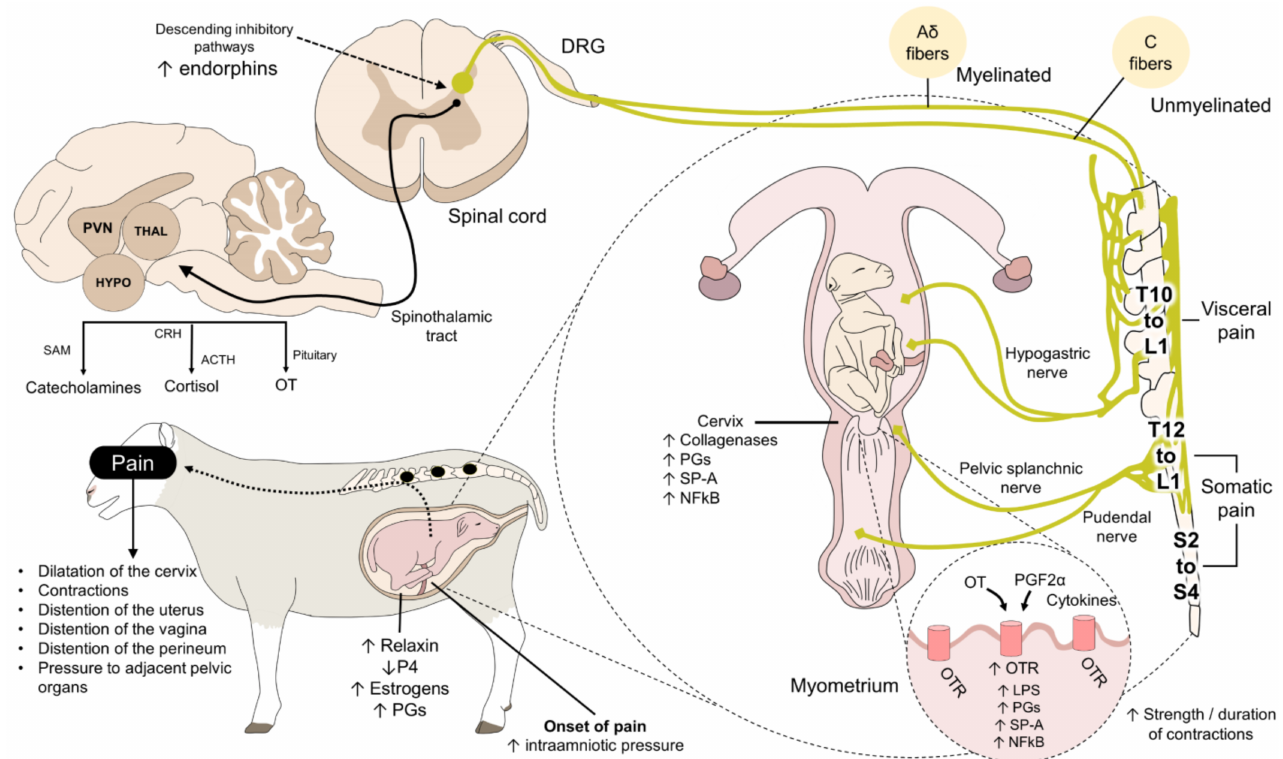
Figure 1. Neurobiology of pain during parturition. With the onset of labor and its clinical signs, such as cervical dilation, myometrial contractions, uterine distention, and increased concentrations of PG, estrogen, collagenase, and other mediators, a nociceptive response is detected by A δ and C fibers. These neurons transmit sensations of visceral and somatic pain to the dorsal horn of the spinal cord, where interneurons modulate and project to supraspinal centers to trigger the conscious perception of pain. Brain areas such as the HYPO and PVN are responsible for generating physiologi- cal responses that trigger secretion of catecholamines, glucocorticoids (cortisol), and OT. OT is the main hormone associated with the onset and maintenance of labor. Its secretion, together with PGF2 α and cytokines, activates OTR to increase the strength, frequency, amplitude, and duration of my- ometrial contractions. ACTH: adrenocorticotropic hormone; CRH: corticotropin-releasing